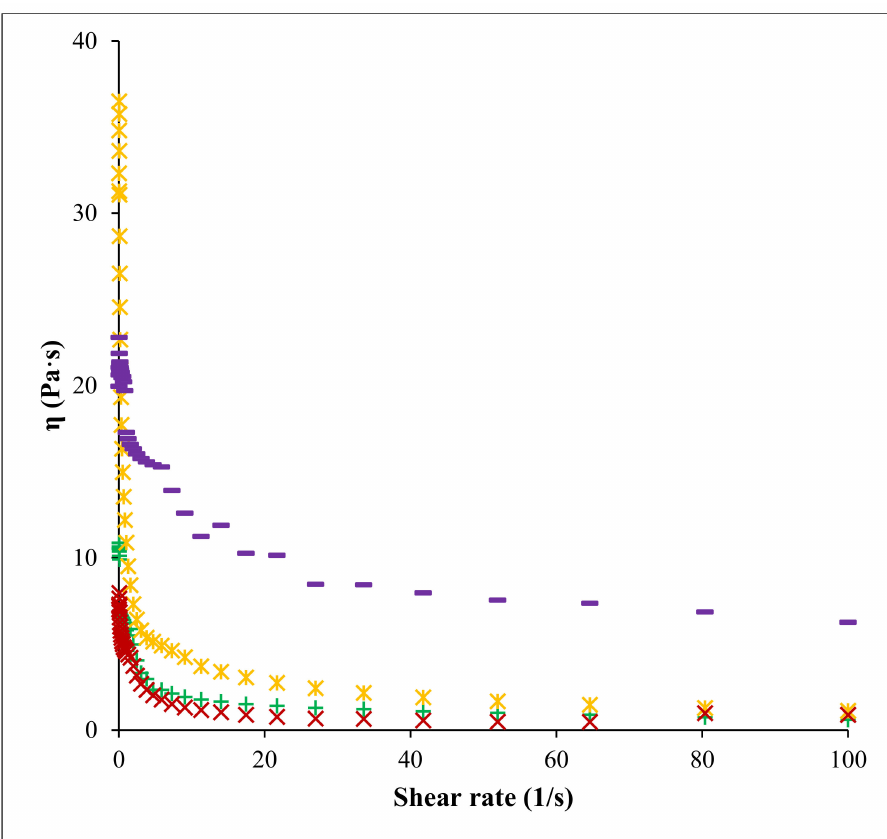
Figure 7. Flow curves of pectin solutions: FN pectin extracted by CE ( + ), RN pectin extracted by CE ( ж ), FN pectin extracted by PUAE ( × ) and RN pectin extracted by PUAE ( – ); η —dynamic viscosity, . γ —shear